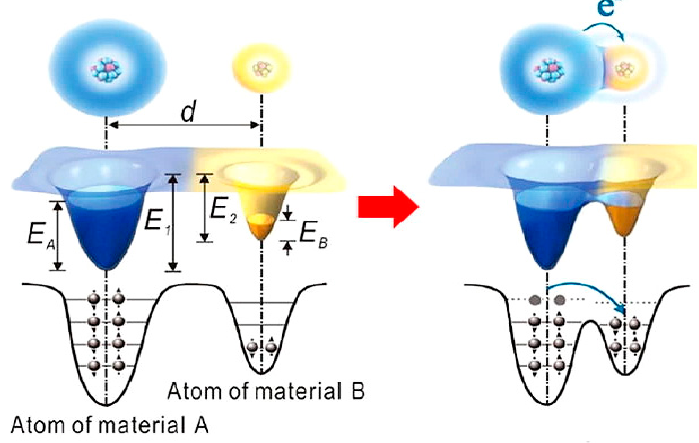
Figure 9. Electron-cloud-potential-well model to explain triboelectrification between two materials [45].